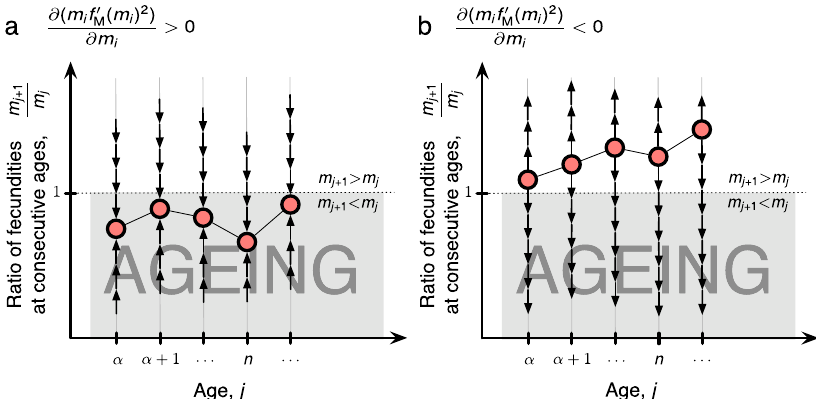
Fig. 2 Evolutionary dynamics of fecundity. a , b Dynamics of fecundity evolution depend on how genetic variation acts on fecundity m i at each age i . There are two main cases that are captured by the function f M (see Methods). a Dynamics, depicted here as arrows, always lead fecundity at one age to be larger than fecundity at the next age and there is at most a single equilibrium with this pattern, which is stable under broad conditions. b There may be at most a single equilibrium where fecundity at one age is smaller than fecundity at the next age, but dynamics always repel